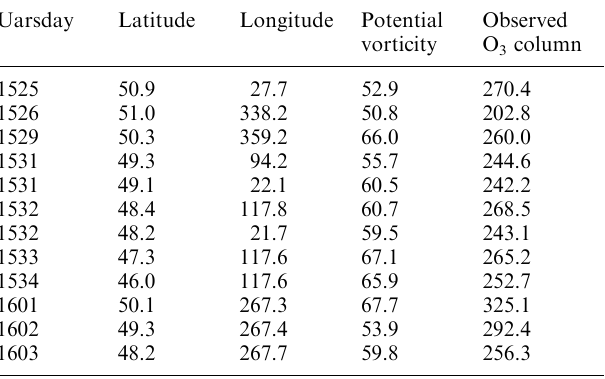
Table 3. The early vortex CH